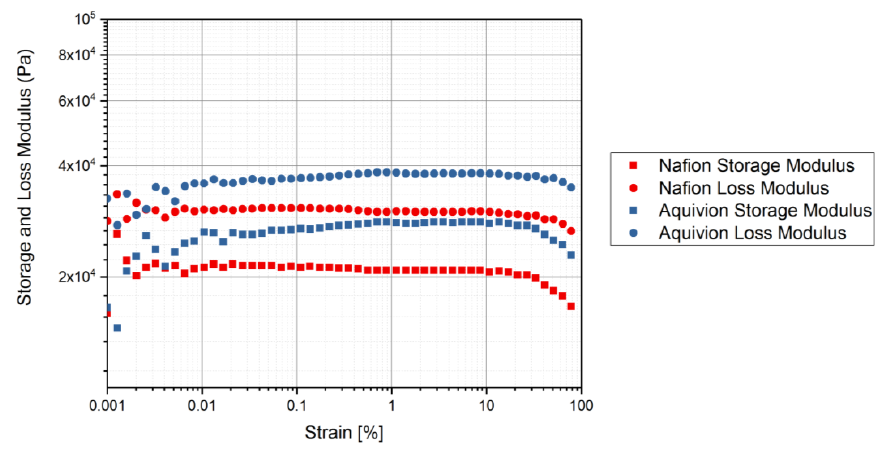
Figure 13. Rheology tests with an applied strain to measure the storage and loss modulus of the precursor-ionomers. Precursor Nafion was tested at 200 °C and precursor Aquivion was tested at 240 °C at a frequency of 1 Hz.